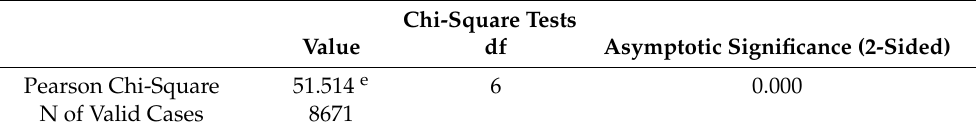
Table 15. Chi-square test (enterprise size vs. change in the ROE 2020 profitability indicator). Source: own